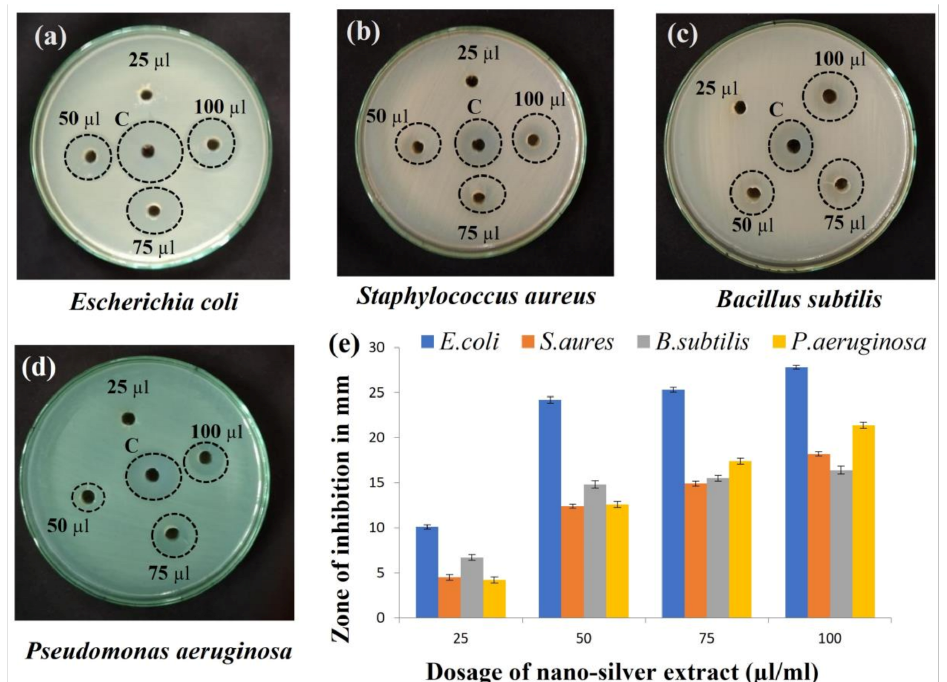
Figure 11. Antibacterial assay of synthesized silver nanoparticles against ( a ) Escherichia coli treated with bio-synthesized AgNPs, showing maximum antimicrobial activity when compared to ( b ) Staphy- lococcus aureus; ( c ) Bacillus subtilis; ( d ) Pseudomonas aeruginosa. Zone of inhibition with different dosage of nanosilver treatments are represented by bar graphs ( e ). Standard deviation ( ± ) shows the mean values of 3 replications. The results are statistically significant with p value <